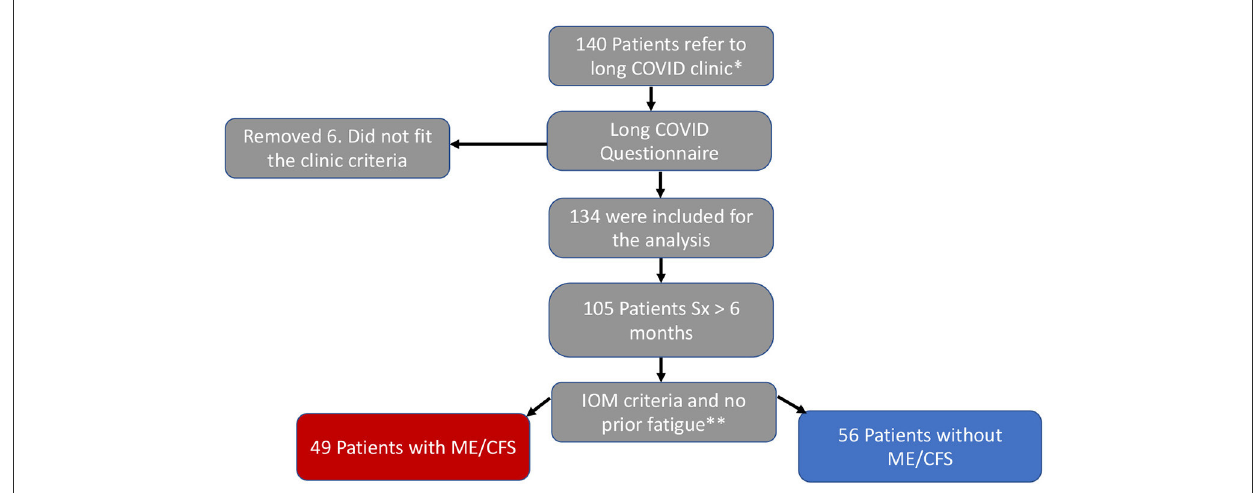
FIGURE1 Flow chart. *Positive SARC-CoV-2 test and over 28 days with symptoms. **Severe fatigue, unrefreshing sleep, PEM, and brain fog or orthostatic intolerance.